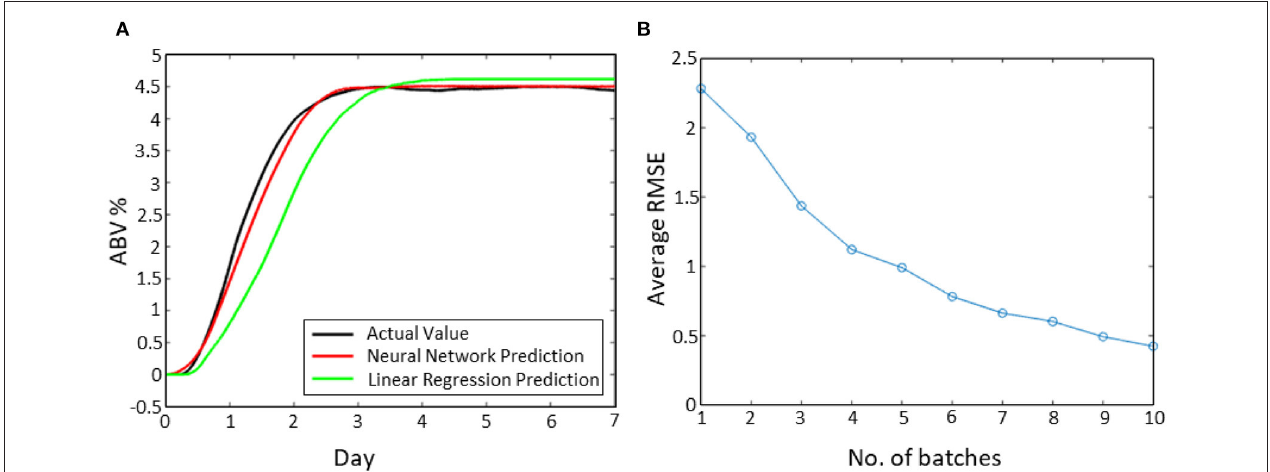
FIGURE 9 | Machine learning results from the lab fermentation experiments. (A) Prediction of the Alcohol by Volume (ABV%) from an Artificial Neural Network (ANN) compared to a linear regression model and the actual measured value. (B) The Root Mean Squared Error (RMSE) of the predictions as a function of number of batches used in the training